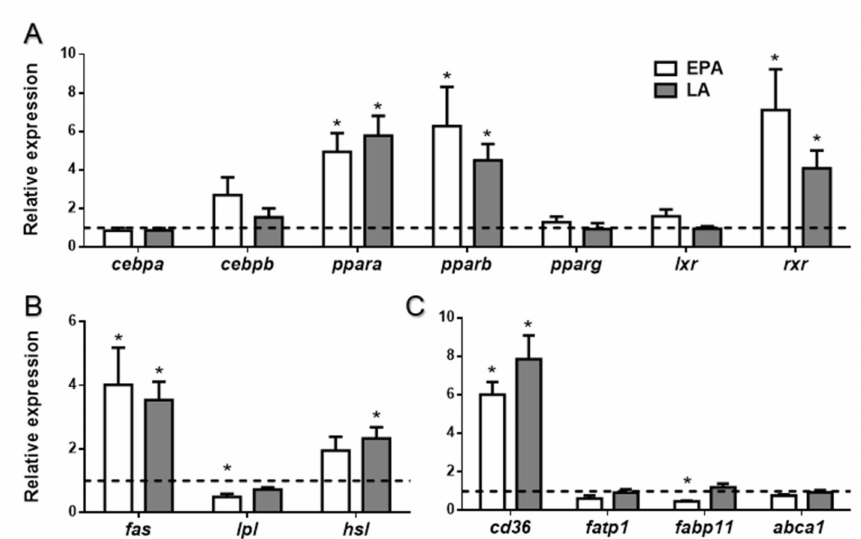
Figure 3. Relative gene expression of ( A ) transcription factors, ( B ) lipid metabolism enzymes, and ( C ) lipid transporters in adipose tissue of rainbow trout at 6 h after being force-fed with EPA, LA, or vehicle without fatty acid as control (dashed line). Data are shown as mean + SEM ( n = 7–9). Significant di ff erences ( p < 0.05) with the control are indicated by asterisks (*) and among treatments by di ff erent letters. EPA: eicosapentaenoic acid; LA: linoleic acid.